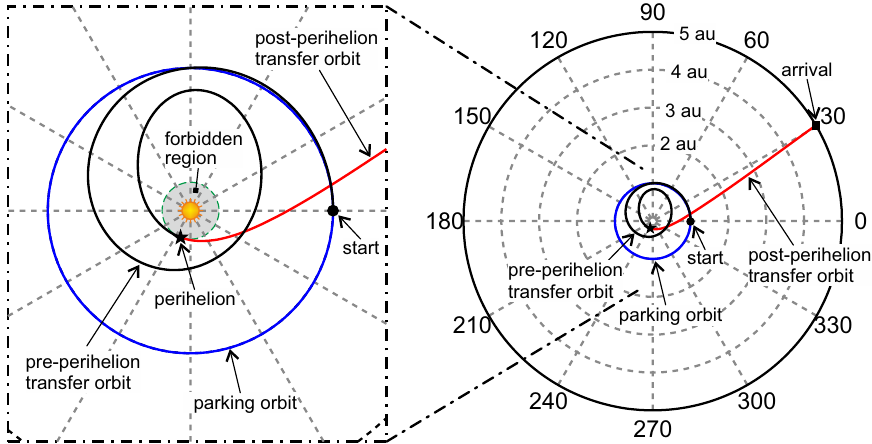
Figure 13. Minimum-time transfer trajectory to reach a heliocentric distance of 5au with a hyperbolic excess velocity V ∞ = 35.5km/s.